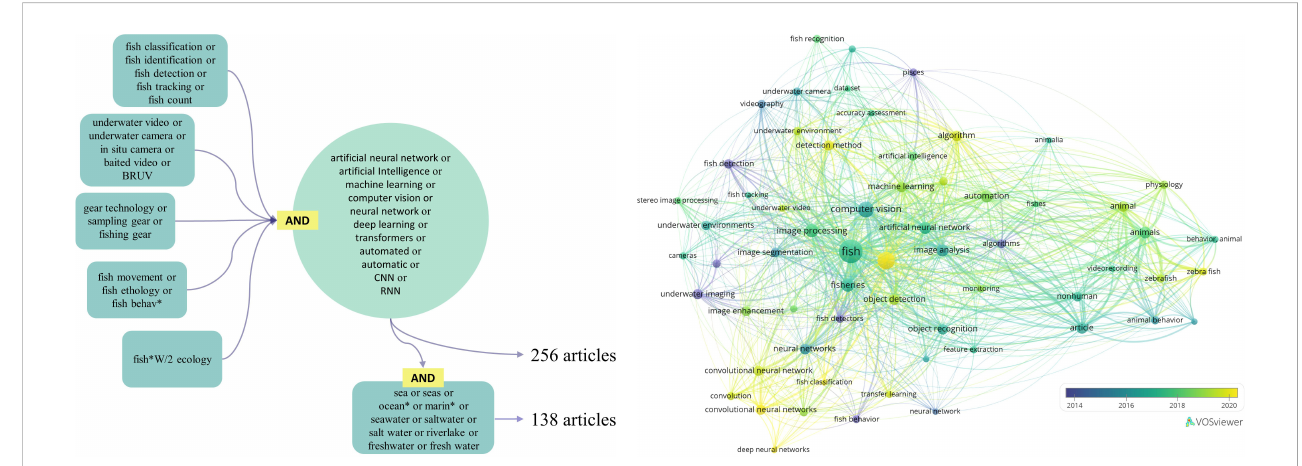
FIGURE 1 Visualization of bibliographic search. Top photo: Set of queries in SCOPUS and number of resulting articles. Fish*W/2 ecology keyword was used to focus the search on ecologically-based studies. Bottom photo: Bibliometric landscape of topics from articles (Linkage of keywords, occurrence >